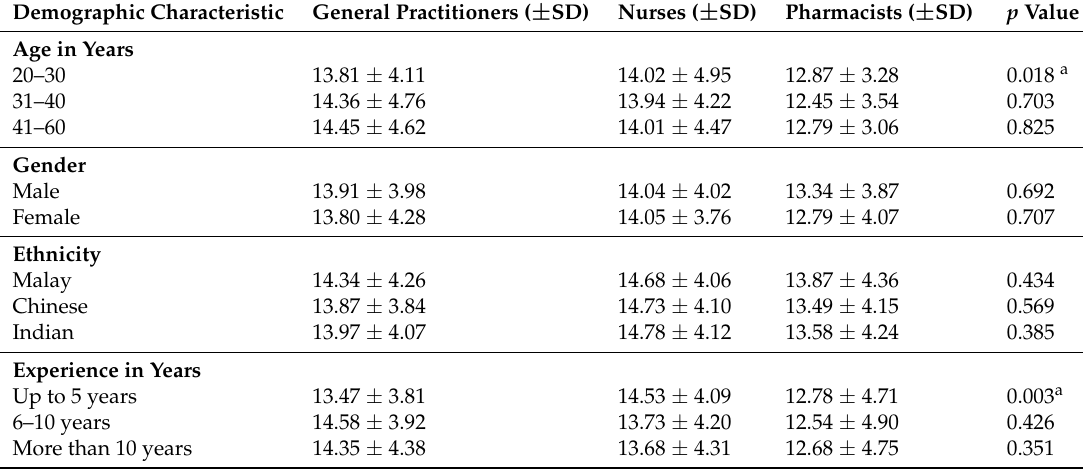
Table 5. Differences in perceived response among healthcare professionals by demographic profile.